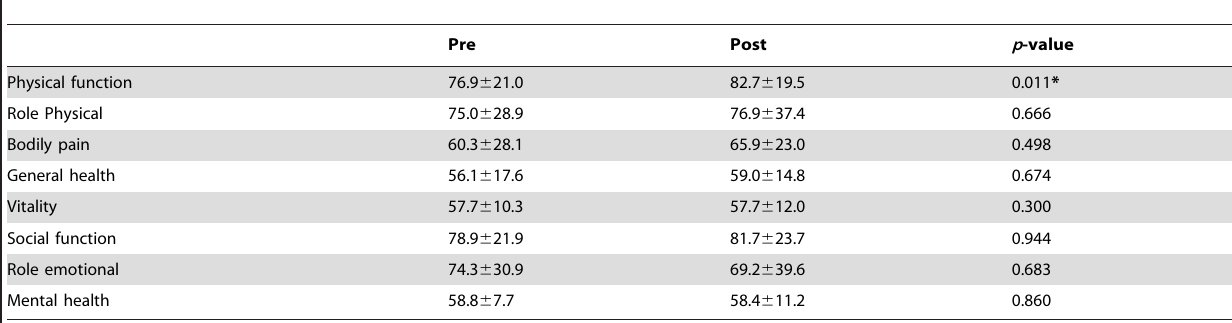
Table 5. SF-36 scores before and after the training program (mean 6